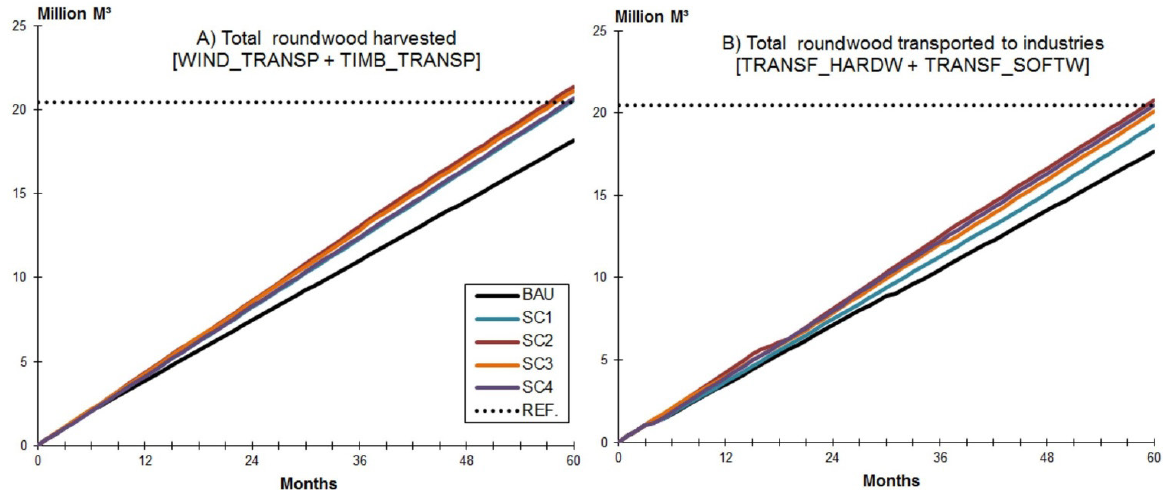
Figure 10. Roundwood (windfalls plus timber) cumulative flows (million m 3 ) for business-as-usual (BAU) and crisis scenarios (SC1 to